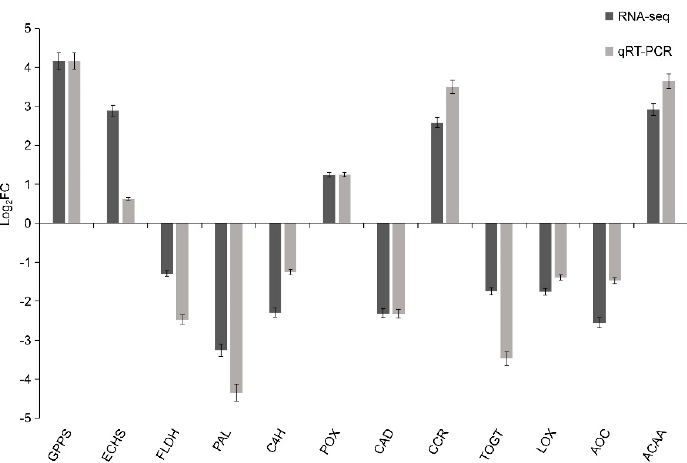
Figure 6. A comparison of differential expressed genes related to floral scent in flowers by RNA-seq and real-time PCR. Limonene and pinene degradation: ECHS, enoyl-CoA hydratase. Terpenoid backbone biosynthesis: GPPS, geranyl diphosphate synthase; FLDH, NAD + -dependent farnesol dehydrogenase. Phenylpropanoid biosynthesis: PAL, phenylalanine ammonia-lyase; C4H, cinnamate